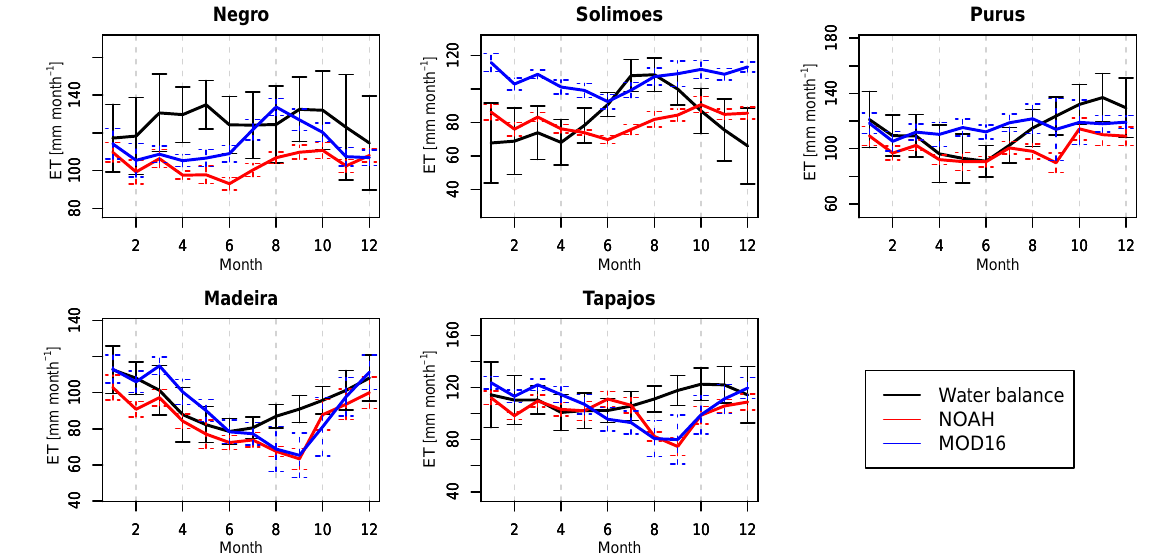
Figure 8. Seasonal ET patterns obtained using the water balance method (black line), NOAH LSM (red), and MODIS MOD16 P-M model (blue). Vertical bars indicate the ± 1 standard deviation of monthly observations from 2001 to 2014. The grey area represents uncertainty in the water budget